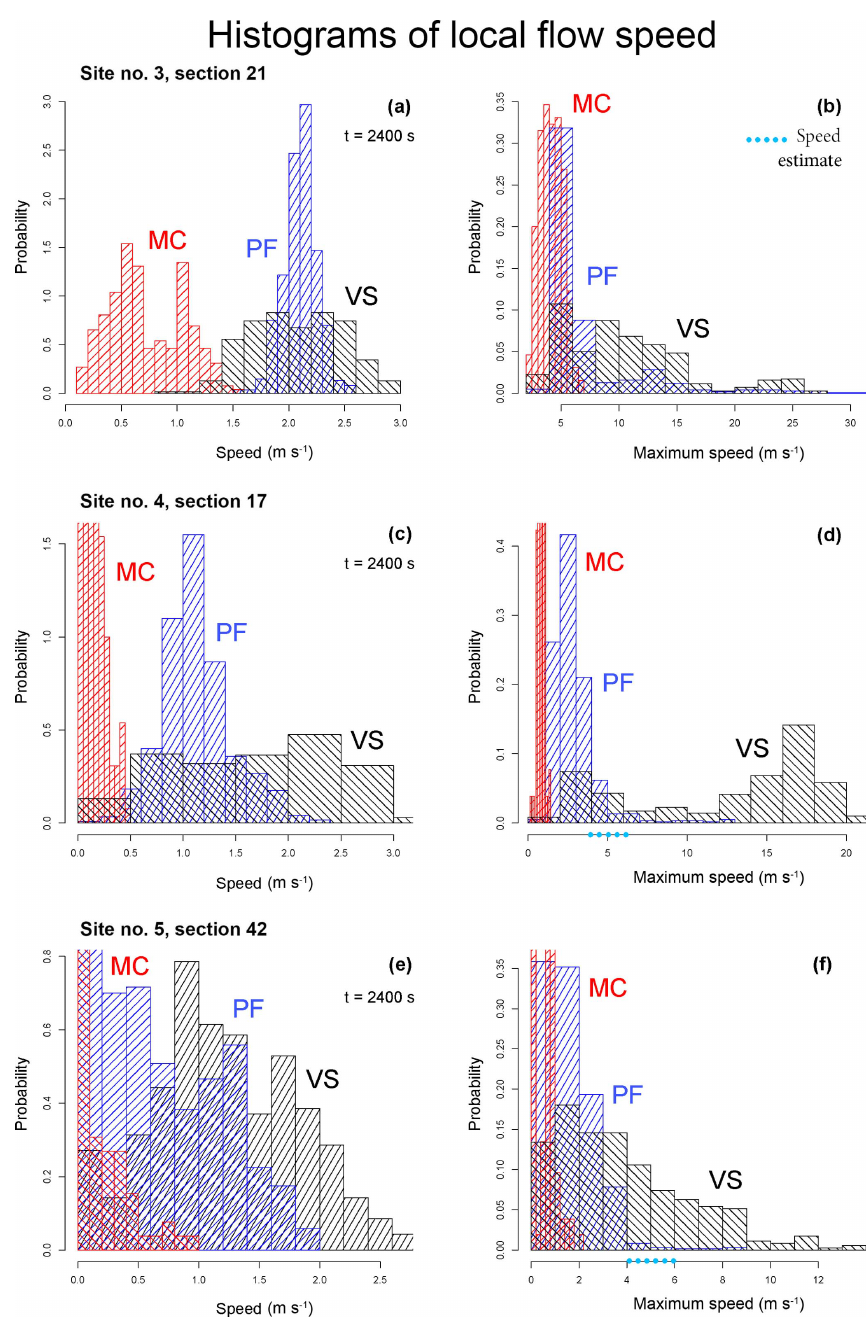
Figure 12. Histograms of local flow speed in sites 3–5. Panels (a, c, e) show speed at t = 2400s, while (b, d, f) show maximum speed. Different models are displayed with different colors. Cyan dots on the speed axis show the uncertainty interval of estimated peak speed (Pierson,